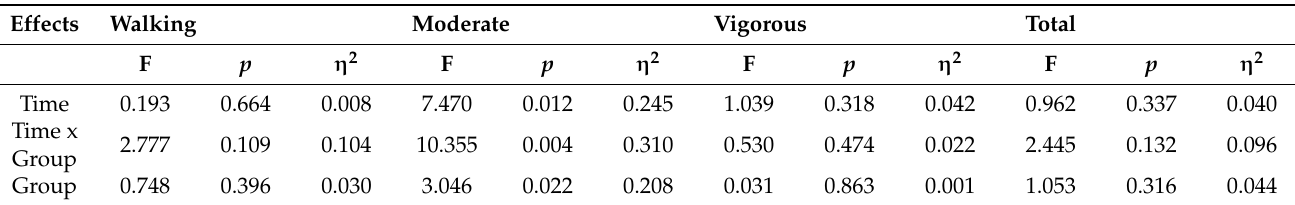
Table 6. Results of ANOVAs with repeated measures for each variable of